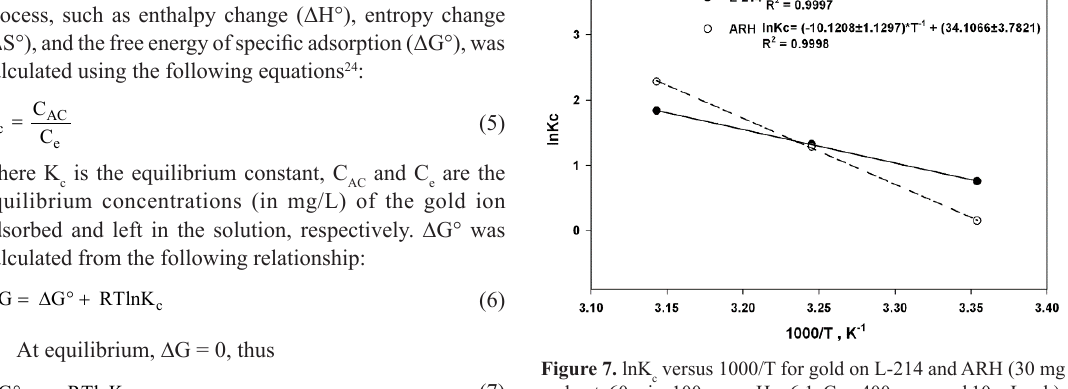
Table 2. Freundlich and Langmuir constants for the adsorption of gold ions at various temperatures.